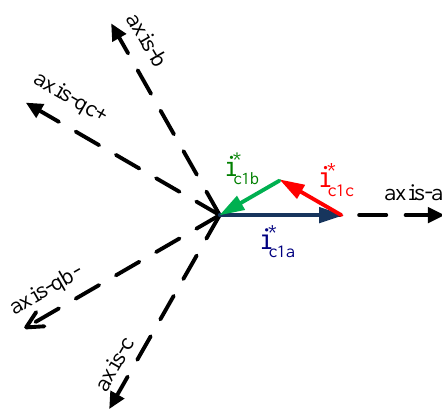
Figure 4. Arm energy balancing controller current vectors for decoupled